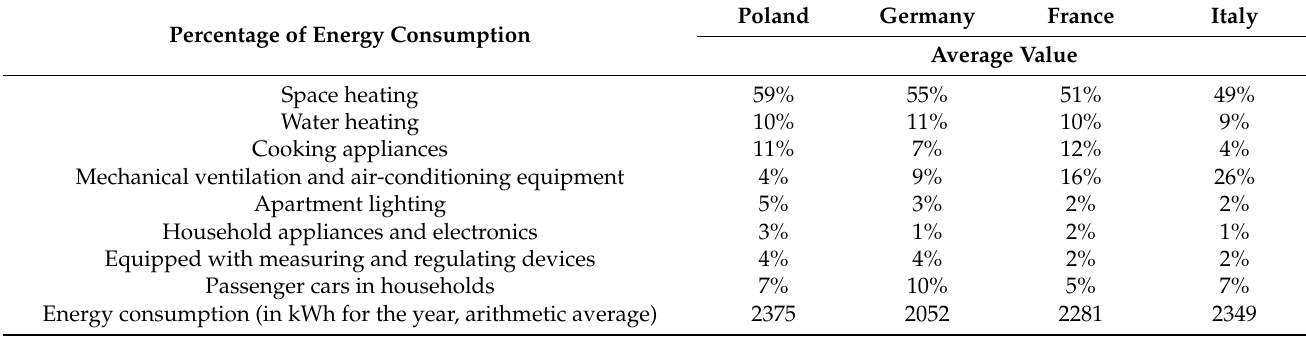
Table 1. Energy consumption in households and the percentage energy consumption (data from